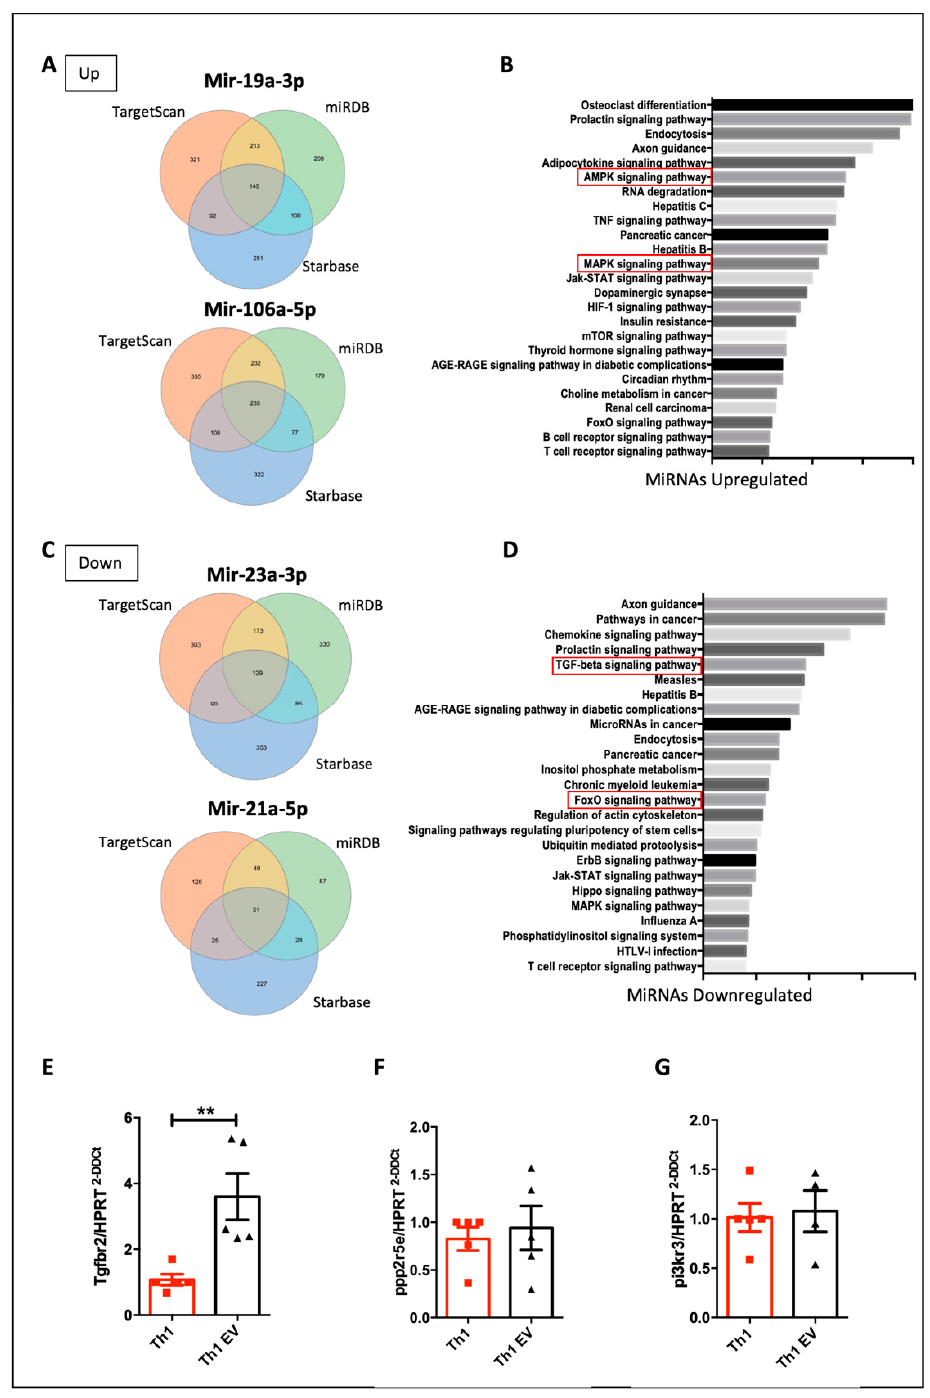
Figure 7. In silico analysis of signaling pathways regulated by miRNAs: Venn diagrams representing the intersection of upregulated ( A ) and downregulated ( C ) miRNAs found in 3 different databases. Biologic processes related to the most overexpressed ( B ) and the most reduced ( D ) miRNAs found by KEGGS pathway analysis on the Enrichr platform. The expressions of TGFBR2 ( E ), PPP2R5E ( F ) and PI3KR3 ( G ) were detected by RT-PCR. n = 5 (** p <0.01). 3.5. Treatment with MSC-EVs Alters the Metabolism of Differentiated T Cells to Th1, Decreasing